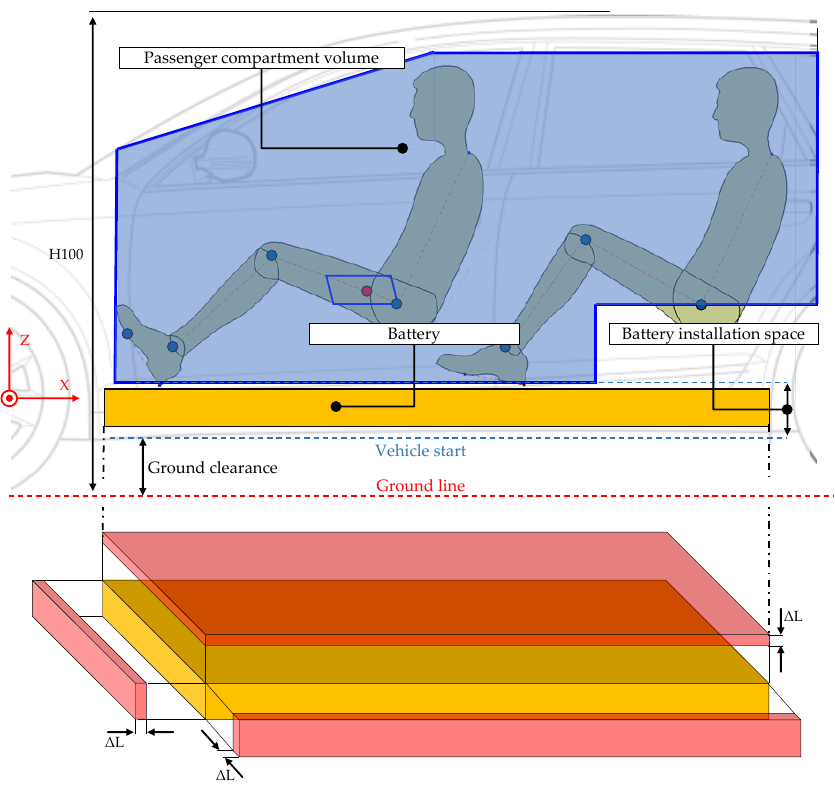
Figure 1. Geometrical correlation between passenger compartment and battery for the Z-direction.